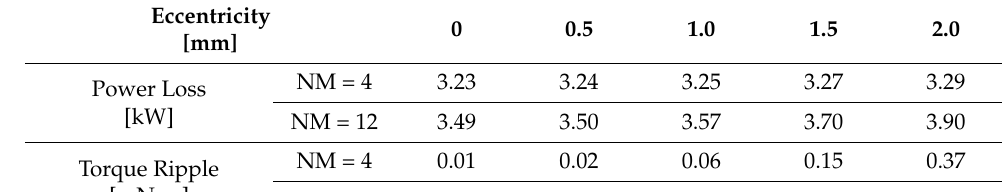
Figure 13. Changes in current density according to eccentricity.